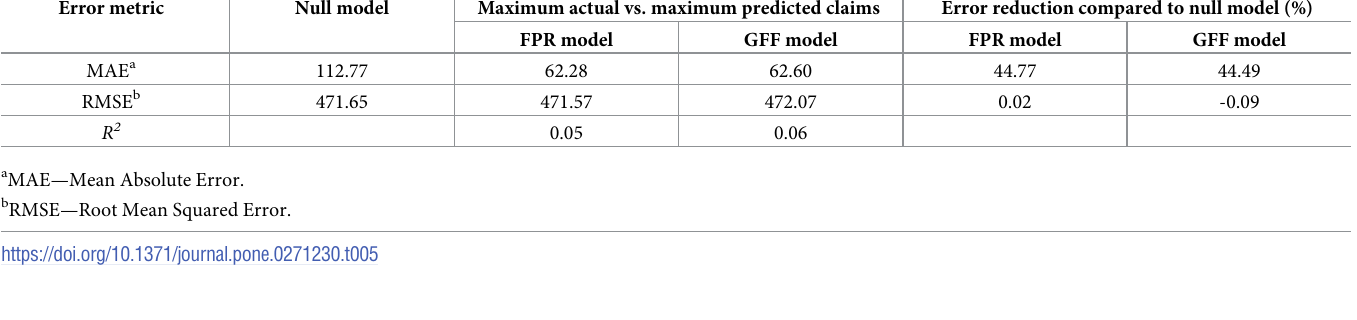
approach has some ability to accurately predict the worst events in a county (as measured by the peak of claims), it has a stronger ability to predict the cumulative number of claims that a county experienced over a year. Similar to the first metric, the higher MAE reduction and lower RMSE reduction relative to the null model show that the FPR and GFF models generally perform better for the events with fewer claims. In the third metric, we identify the predicted and actual events in each county with any temporal overlap, and for all those events in a given county, compare the sum of the number of predicted and actual claims. The goal of this metric is to assess generally how well the two- stage approach is at predicting the correct number of claims at the approximate right point in time. However, it is unable to capture error produced by erroneously predicting a flood event that did not actually occur (and thus potentially predicting erroneous claims), and error pro- duced by predicting an event that did occur, but at a different point in time. The null model is Table 5. Comparison of the maximum actual number of claims from actual events versus the maximum predicted number of claims from predicted events using the state-level analysis in 2016 at the county level. Error